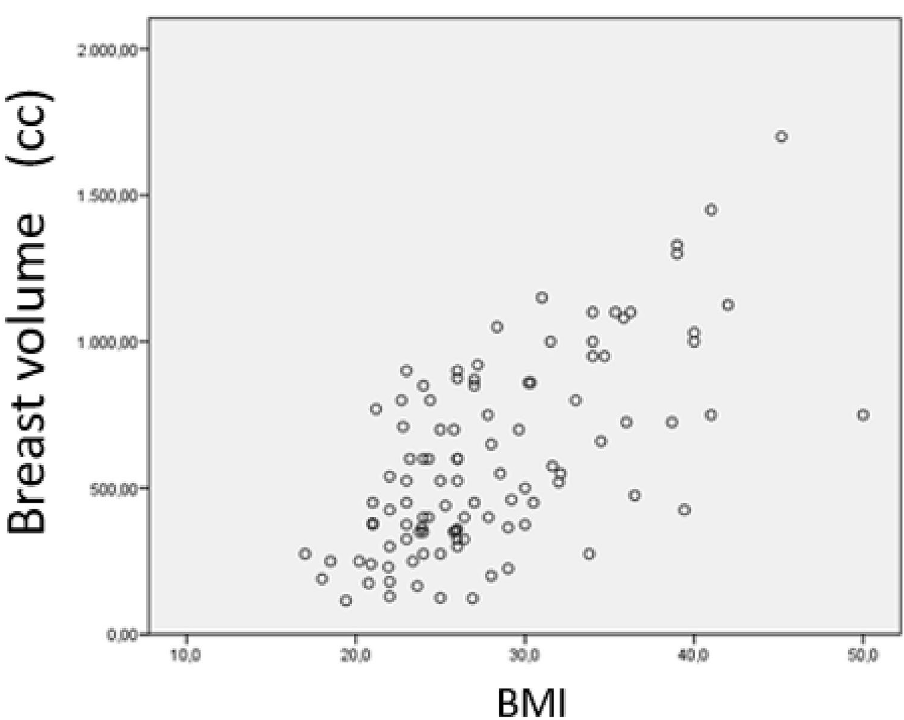
Figure 1. Relationship between Breast Volume and BMI in all patients with breast cancer. Pearson correlation coefficient. r = 0.65; ( p = 0.000). Breast volume (cc): breast volume measured by Archimedes’ method (cubic centimeters). BMI: body mass